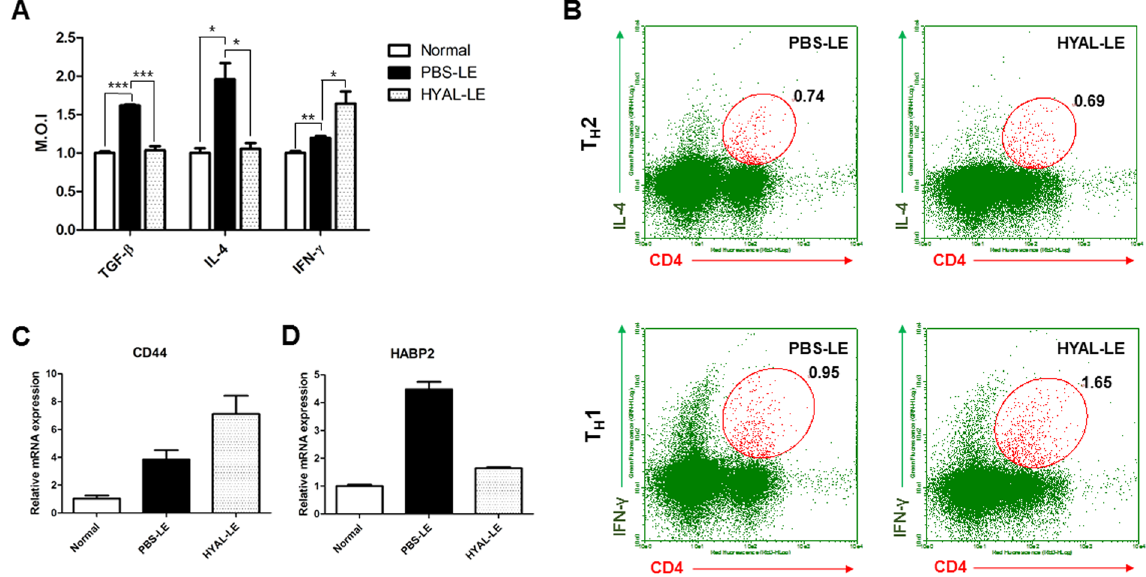
Figure 6. Hyaluronidase injection significantly alters splenocyte T cell populations. Analysis of cytokine expression and T h cell population analysis in total mouse spleen tissue. ( A ) ELISA analysis of the levels of TGF- β , IL-4, IFN- γ on spleen. Data are expressed as median optical intensities. Data are presented as means ± SEMs. ( B ) Representative flow cytometry results of T H 1 and T H 2 cell populations. Data are presented as means ± SEMs. ( C , D ) Quantitative real-time PCR analysis of IL-6 and HABP2 mRNA expression. Data are presented as means ± SEMs. * P < 0.05, ** P < 0.005, *** P <